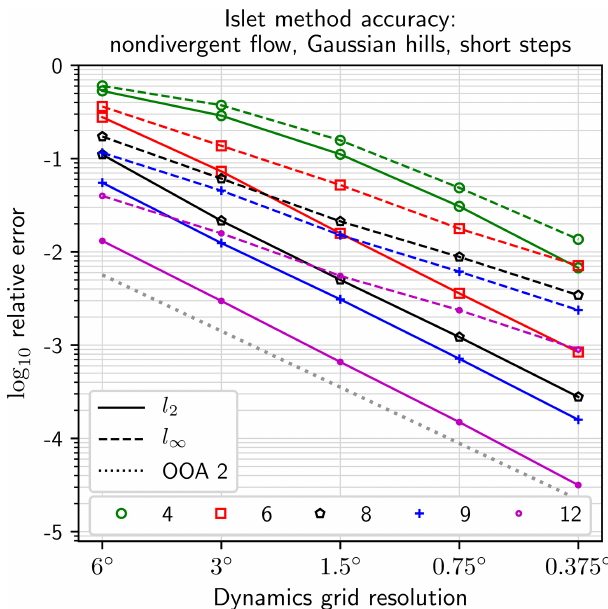
Figure 5. Accuracy diagnostic. Compare with Figs. 1 and 2 in TR14.